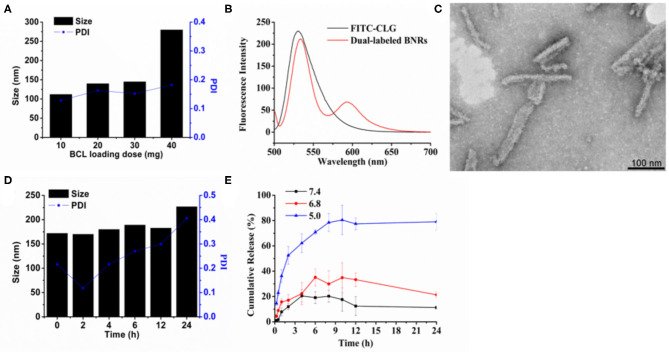
Preparation and characterization. (A) Effect of baicalein loading on the particle size of BNRs. (B) Fluorescence emission spectra for FRET assay. FITC and RITC were used to label CLG and the drug crystals, respectively. Dual-labeled BNRs were prepared by coating the RITC-labeled drug crystals with FITC-CLG. Excitation wavelength: 492 nm. (C) TEM image of optimized formulation (scale bar = 100 nm). (D) Particle-size change of BNRs in 10% serum at 37°C for 12 h. (E)
in vitro release of baicalein from BNRs in buffer solution at pH of 5.0, 6.8, and 7.4 at 37°C for 24 h.